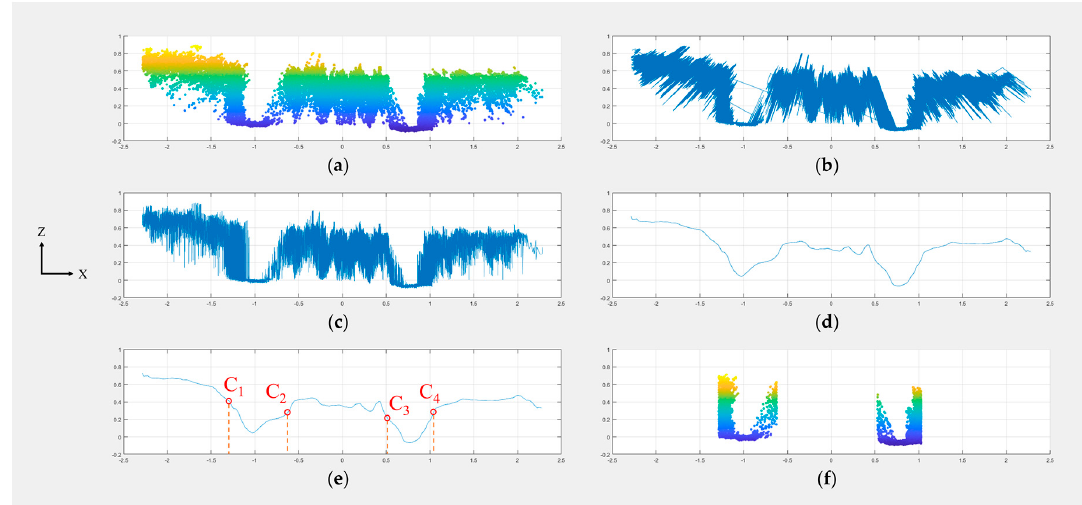
Figure A2. An example of extracting coarse alleyway point clouds: ( a ) point cloud before rotation; ( b ) line graph before sorting; ( c ) line graph after sorting; ( d ) smoothed line; ( e ) positions of the four most significant changes; ( f ) deletion of points beyond the desired range.